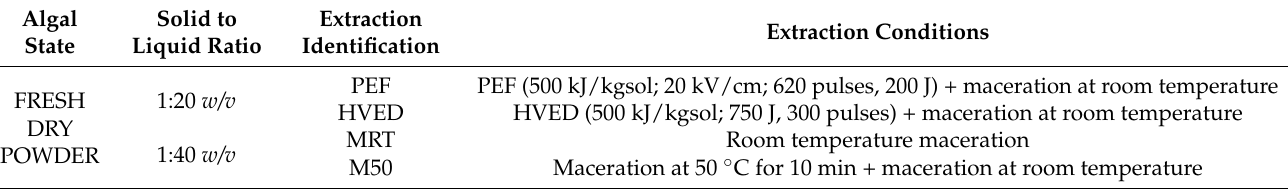
Table 1. State of algae and treatment